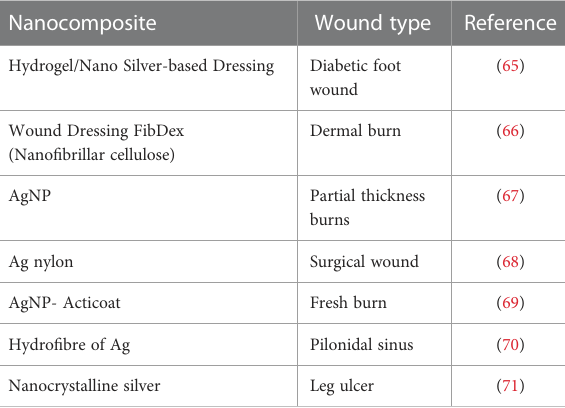
TABLE 2 List nanocomposite scaffolds undergoing/completed clinical